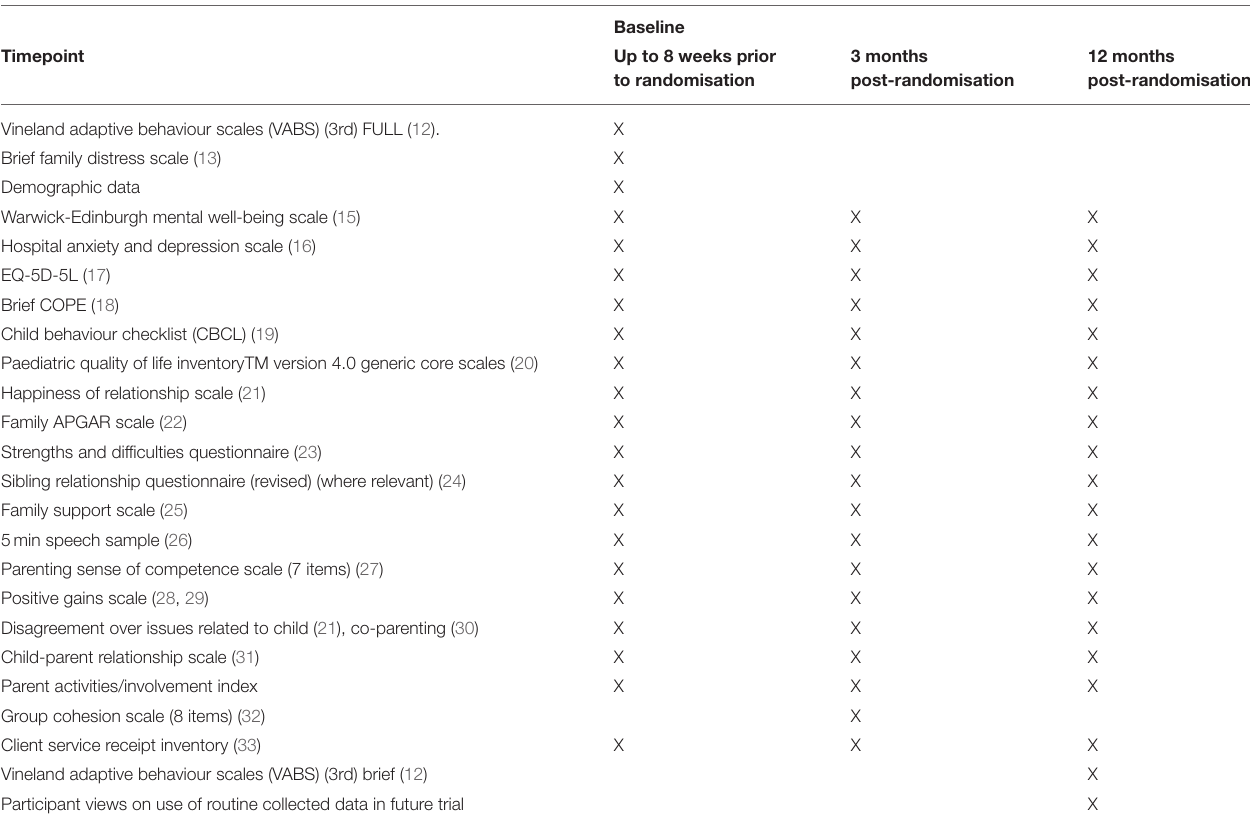
TABLE 2 | Timings of outcome measures.